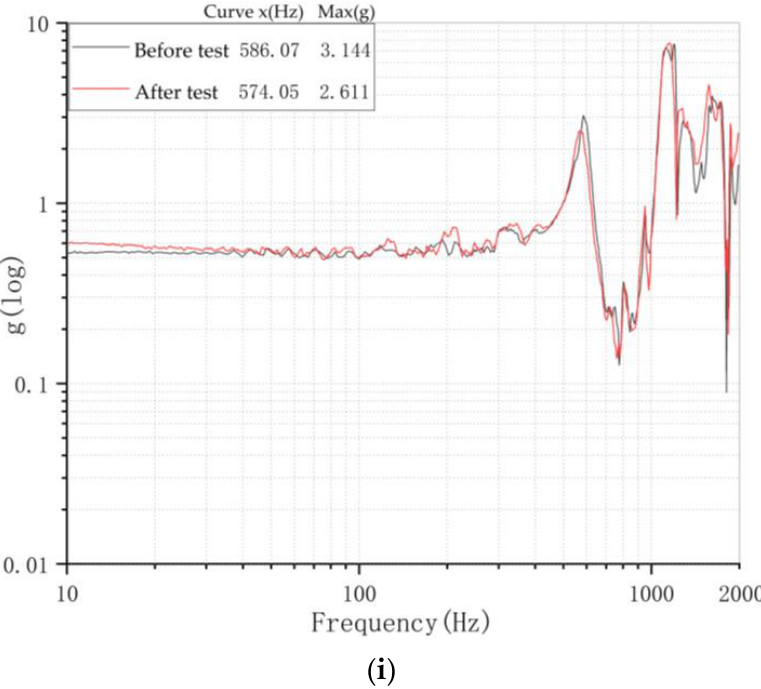
Figure 10. Plots of characteristic swept spectral lines before and after the sinusoidal characteristic sweep frequency test in X, Y, and Z directions for each measurement point: ( a ) Measurement point 1 in X-direction. ( b ) Measurement point 2 in X-direction. ( c ) Measurement point 3 in X-direction. ( d ) Measurement point 1 in Y-direction. ( e ) Measurement point 2 in Y-direction. ( f ) Measurement point 3 in Y-direction. ( g ) Measurement point 1 in Z-direction. ( h ) Measurement point 2 in Z-direction. ( i ) Measurement point 3 in Z-direction.